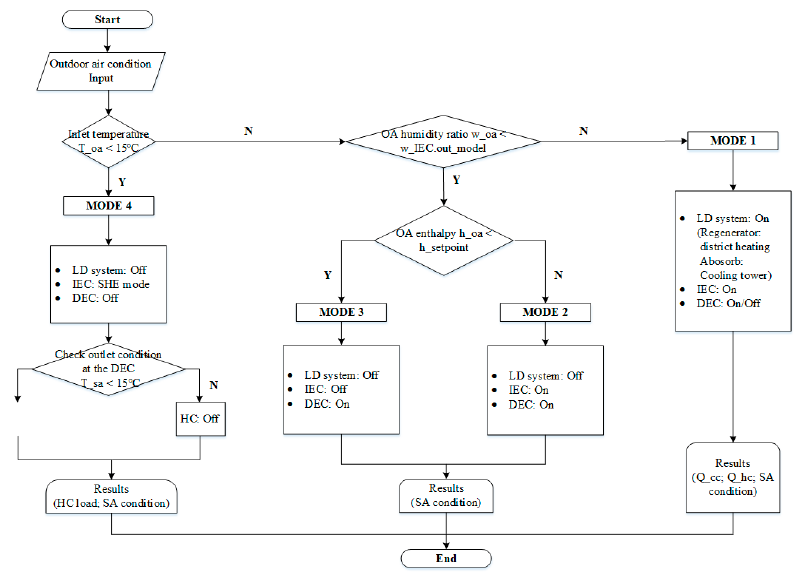
Figure 12. The flow chart of the LD-IDECOAS simulation process.